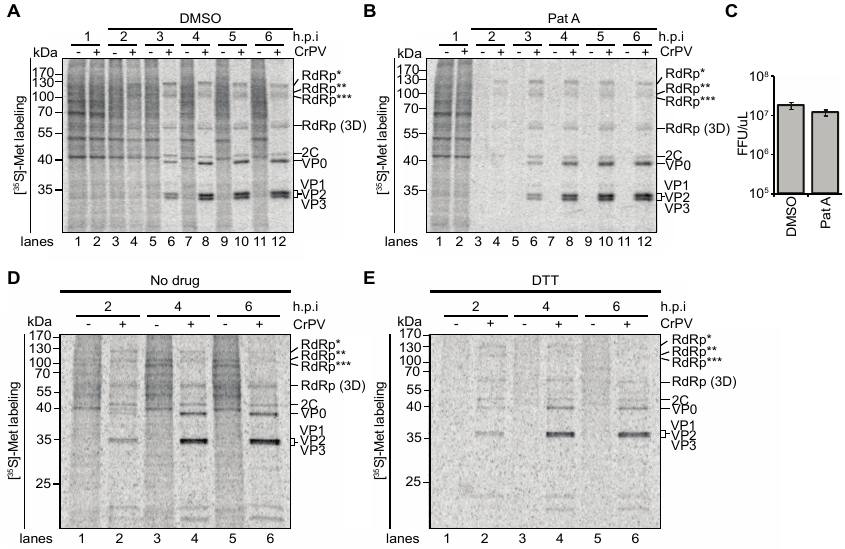
Figure 6. Effects of pateamine A (PatA) and DTT on CrPV protein synthesis. Pulse-labelled protein lysates from mock- or CrPV-infected (MOI 10) S2 cells treated with either ( A ) DMSO; ( B ) 50 nM pateamine A; ( E ) 50 nM DTT; ( D ) or left untreated were resolved on a 12% SDS-PAGE gel. The cells were metabolically labelled with [ 35 S]-Met/Cys for twenty minutes at the end of each time point. Shown are representative autoradiographs from at least three independent experiments; ( C ) Viral titers from infected lysates treated with DMSO or PatA after 10 h.p.i. RdRp*, RdRp**, and RdRp*** denote polyproteins containing RdRp at the approximate sizes of 120 kDa, 105 kDa, and 100 kDa respectively.